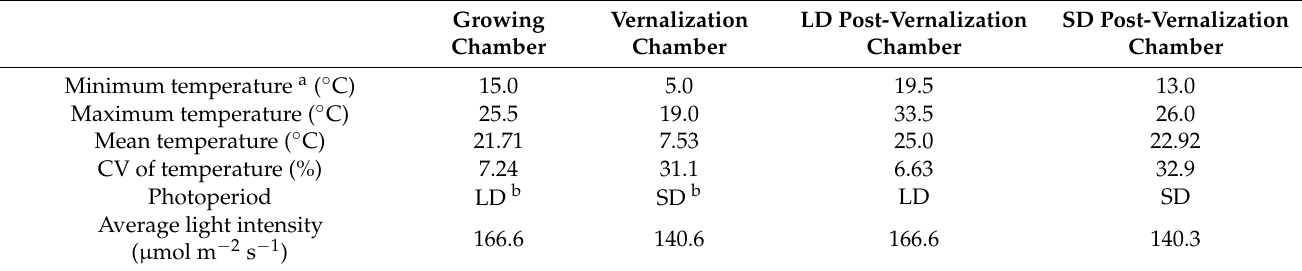
Table 3. Temperature, photoperiod, and light intensity conditions in each chamber used for car- rot